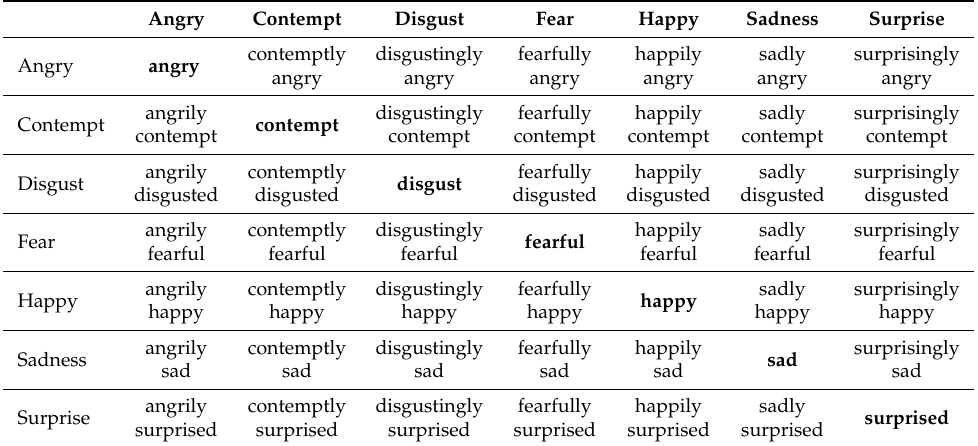
Table 1. 49 Dominant–complementary emotion combinations (the 50th emotion is